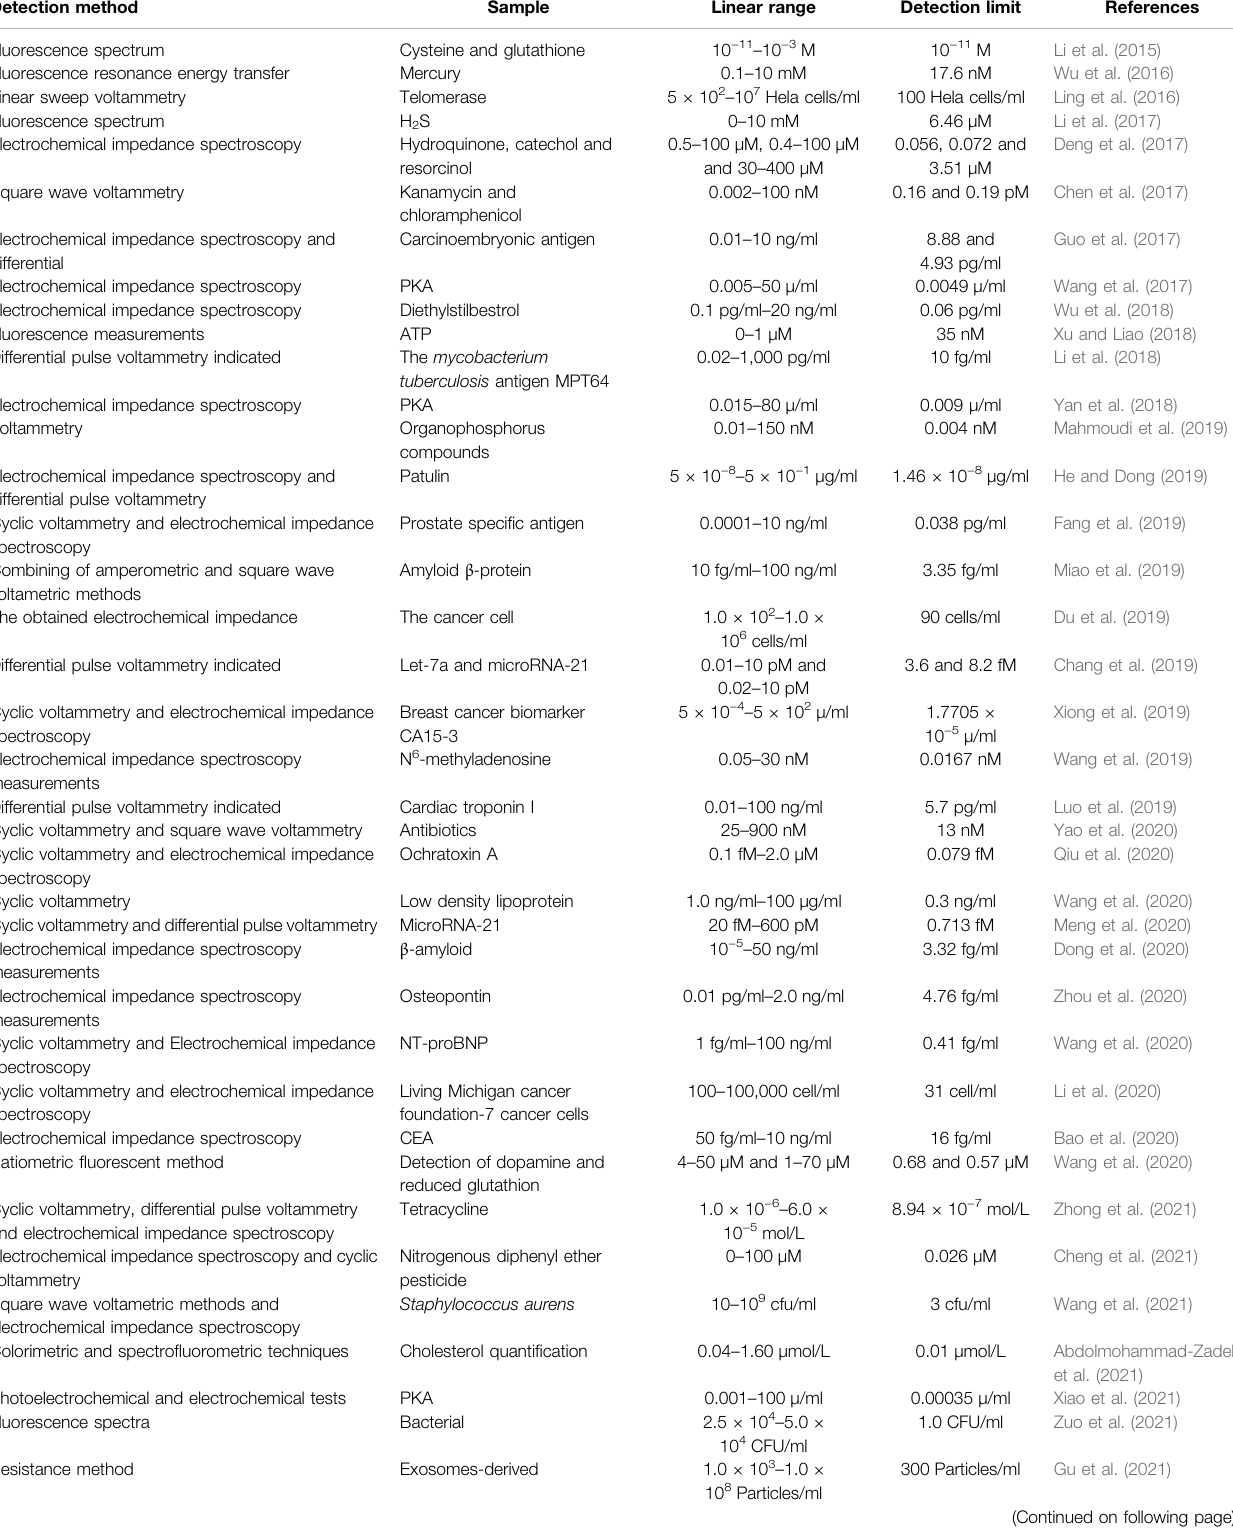
TABLE 1 | Performance of